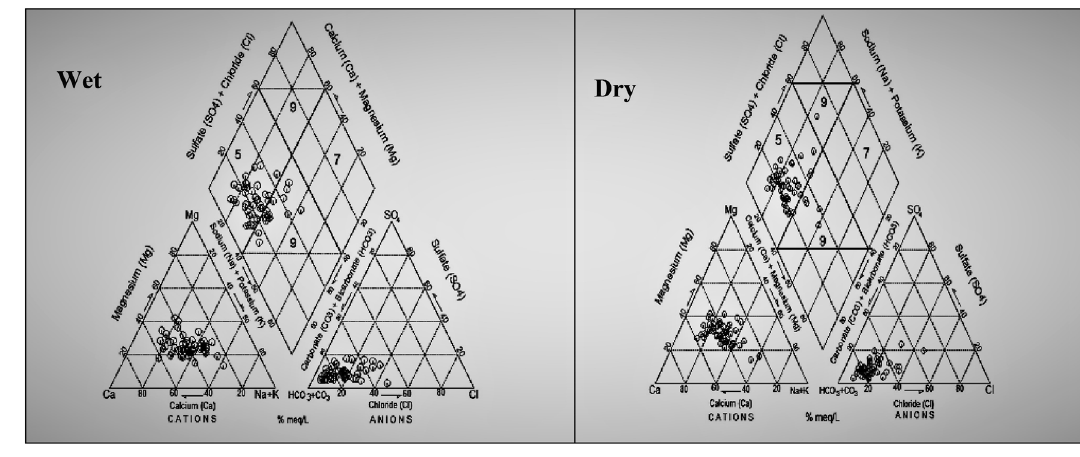
Fig. 11 Piper diagram of GW samples